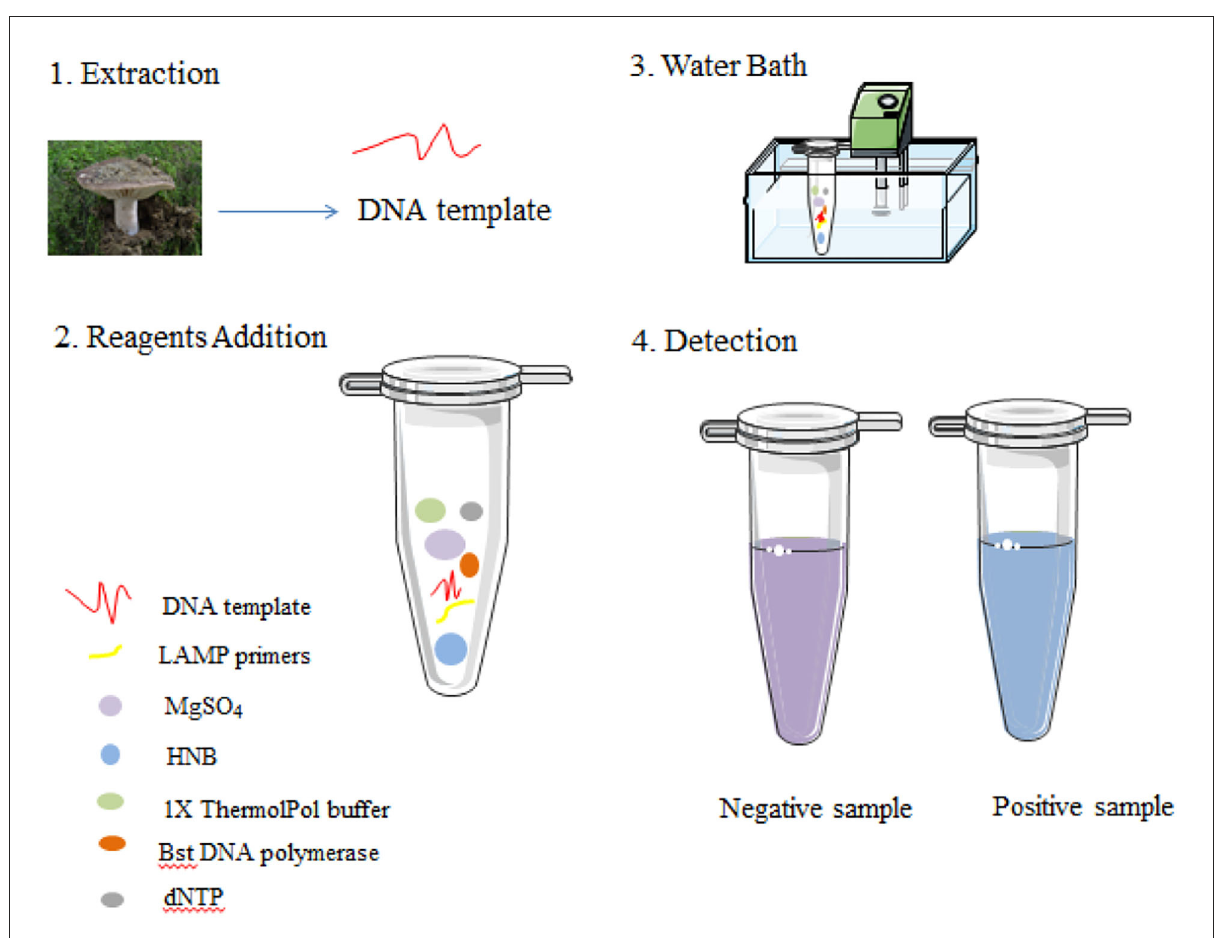
FIGURE3 Schematic illustration of the LAMP